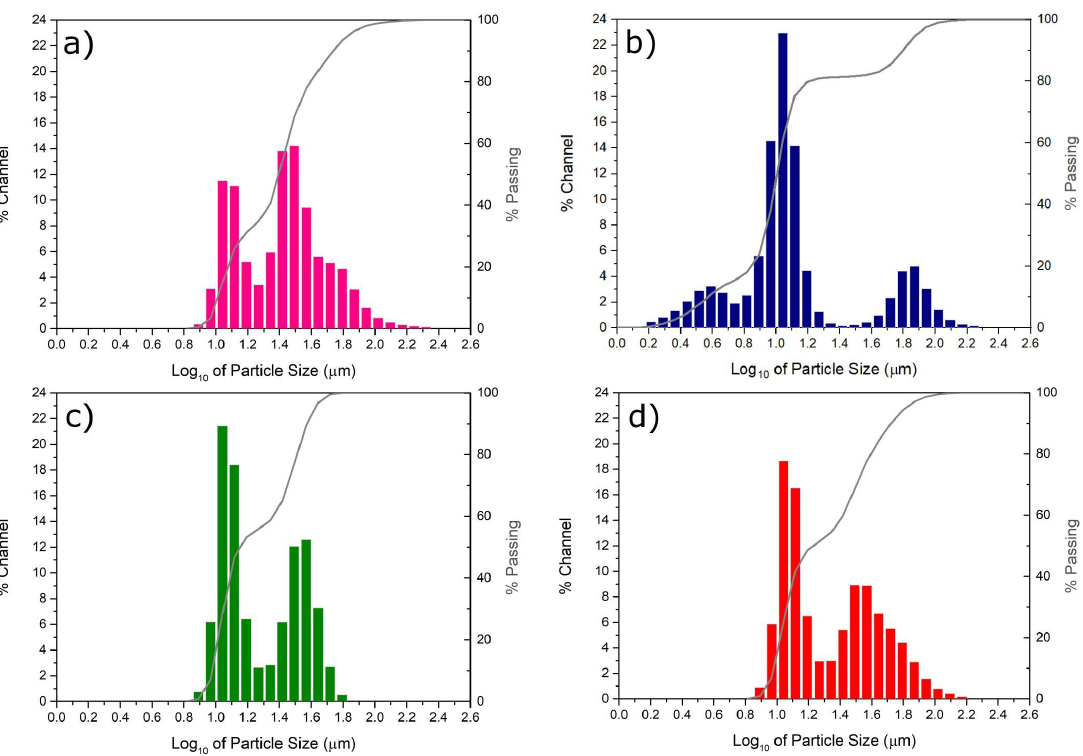
Figure 6. Particle size distribution for each alloy condition (a) Fe-15at.%Nb samples without PCA (reference), (b) Fe-15at.%Nb samples with methanol PCA, (c) Fe-15at.%Nb samples with hexane PCA and (d) Fe-15at.%Nb samples with stearic acid PCA for 80 hours MA.